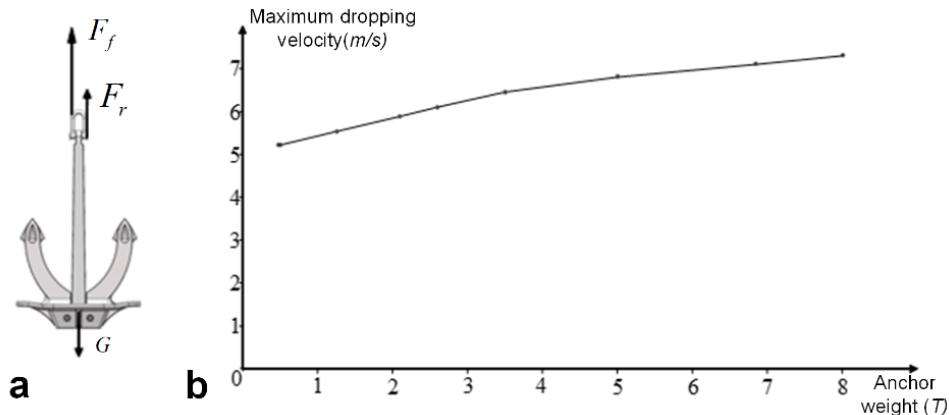
Figure 2. ( a ) The forces acting on the anchor when dropping in the water, and ( b ) the maximum dropping velocity of the anchor.